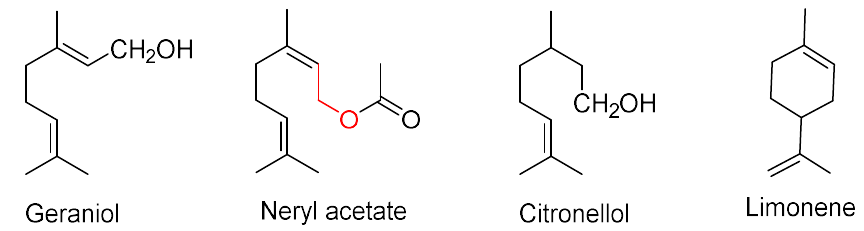
Figure 4. Structures of the active components from lemon and geranium oils.